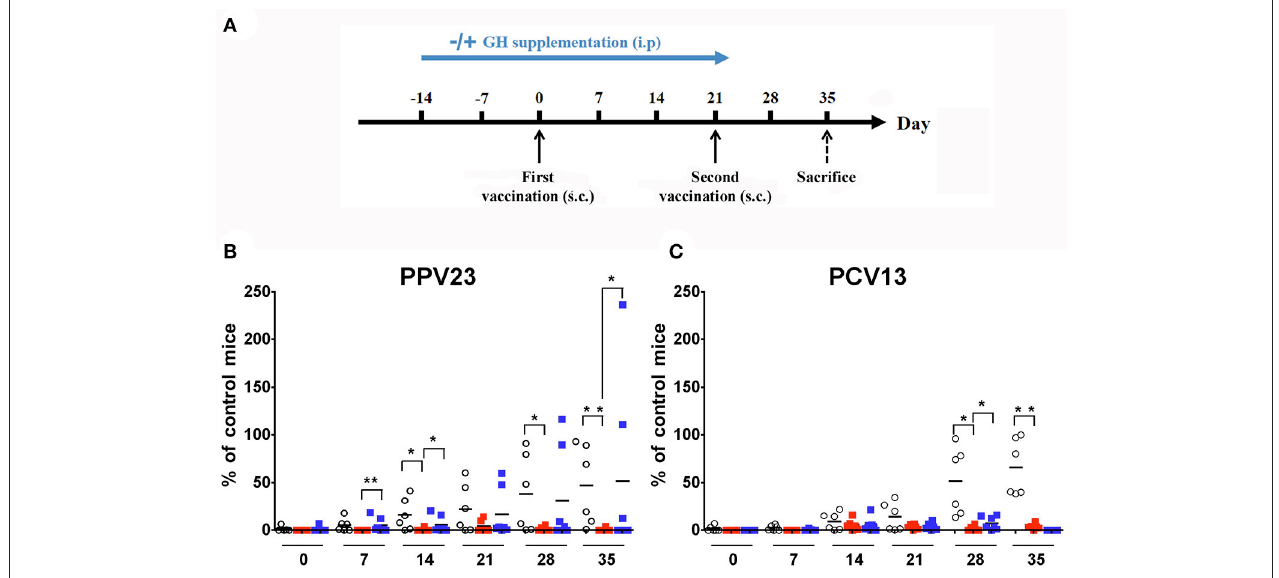
FIGURE 1 | Vaccinal response to S. pneumoniae vaccines. (A) Experimental protocol for S. pneumoniae vaccination and hGH supplementation. KO and WT mice were immunized with PPV23 or PCV13 vaccine at days 0 and 21. HGH was supplemented to the Ghrh − / − mice for 5 weeks (2 weeks before and 3 weeks after the first vaccination). The animals were bled prior to administration of the immunization dose and each week at day 0, 7, 14, 21, 28 and 35. s.c., subcutaneous. (B,C) Percentage of IgM antibodies from WT ( ◦ ), unsupplemented KO ( ) and supplemented KO mice ( ) related to internal control. All results are presented as individual response and mean. N = 6 mice per group. * p < 0.05; ** p < 0.001 (Mann-Whitney U -test).